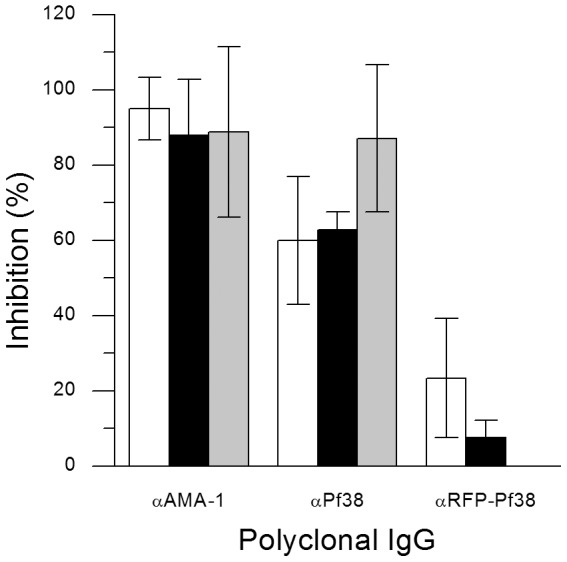

In vitro growth inhibition of 3D7A parasites with αPf38 antibodies.A GIA was performed with P. falciparum 3D7A parasites and protein G-purified IgG fractions. αAMA-1: Rabbit αAMA-1 IgG fraction (positive control); αPf38: murine αPf38 IgG fraction; αRFP-Pf38: murine αRFP-Pf38 IgG fraction. Each experiment (represented by one bar in the graph) was performed in triplicate. Bars depicted in the same colour indicate experiments that were performed in parallel. Inhibition was calculated as described in the materials and methods.